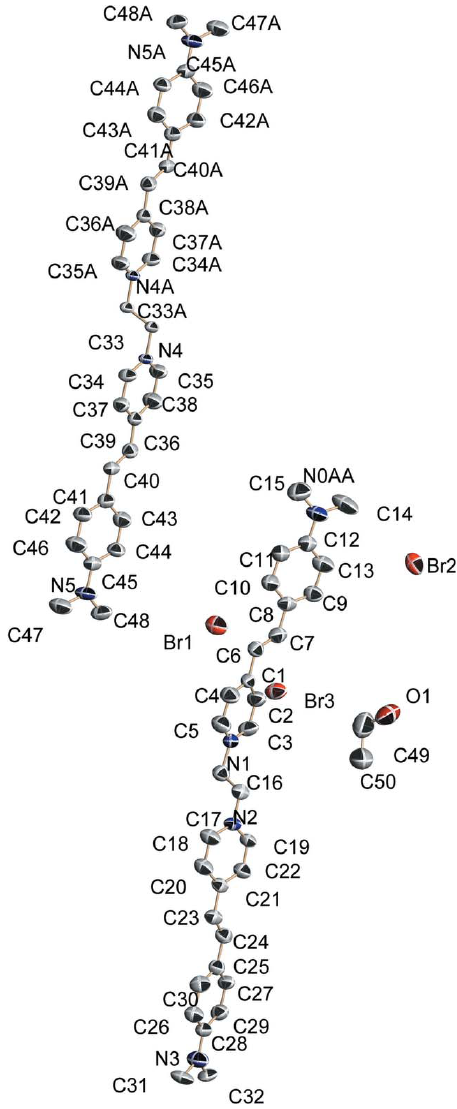
Figure 1 The molecular structure of the title compound, with displacement ellipsoids drawn at the 30% probability level; H atoms are omitted for